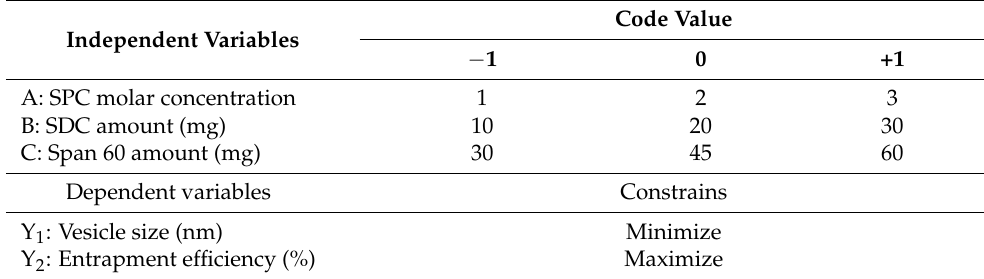
Table 1. 3 3 BBD design for optimization of SMV-loaded